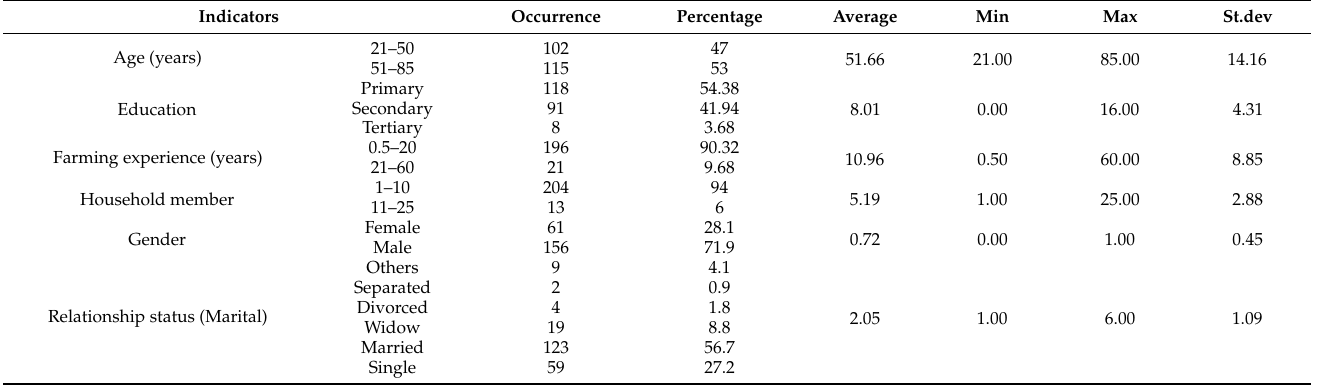
Table 3. Socio-economic characteristics of the respondents ( n =